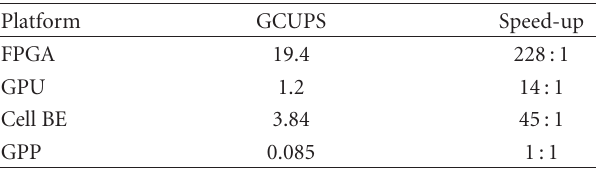
Table 6: Cost of purchase and development of the Smith-Waterman algorithm implementation on all four technologies.